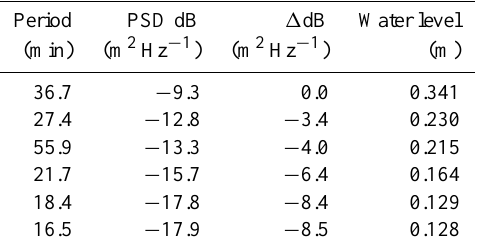
Table 3. Mean water level spectral amplitudes at the bay-wide os- cillation modes estimated from 1Hz nontide residuals over 63days. The 95% confidence interval on spectral amplitude is 3.0dB.